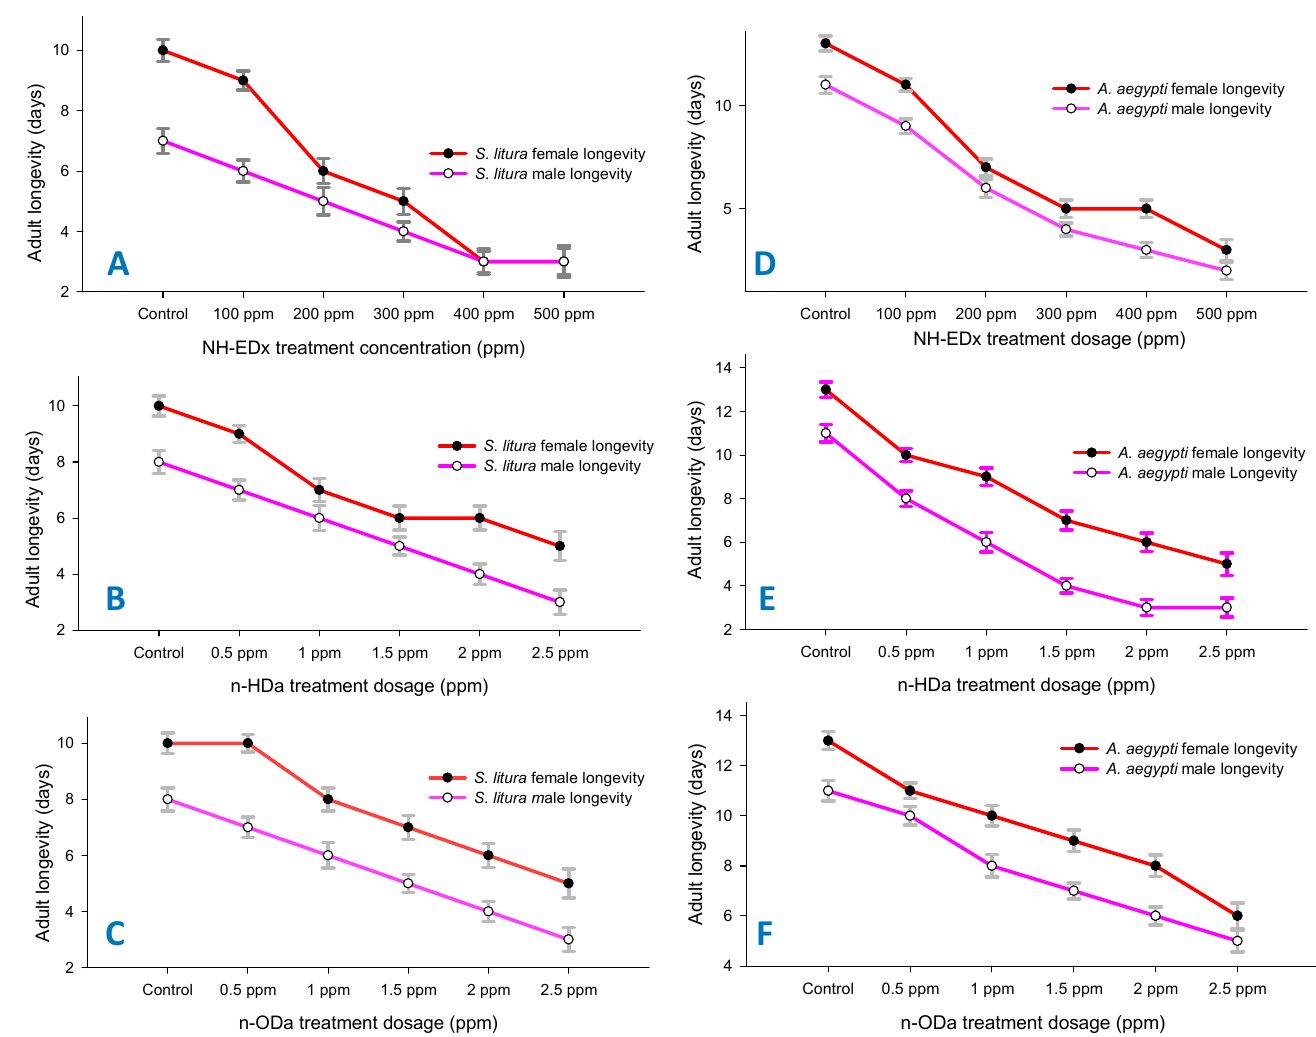
Figure 6. Developmental time in days for S. litura adults after treatment with ( A ) NH-EDx, ( B ) n -HDa, and ( C ) n -ODa, and for A. aegypti adults after treatment with ( D ) NH-EDx, ( E ) n -HDa, and ( F ) n -ODa, respectively.